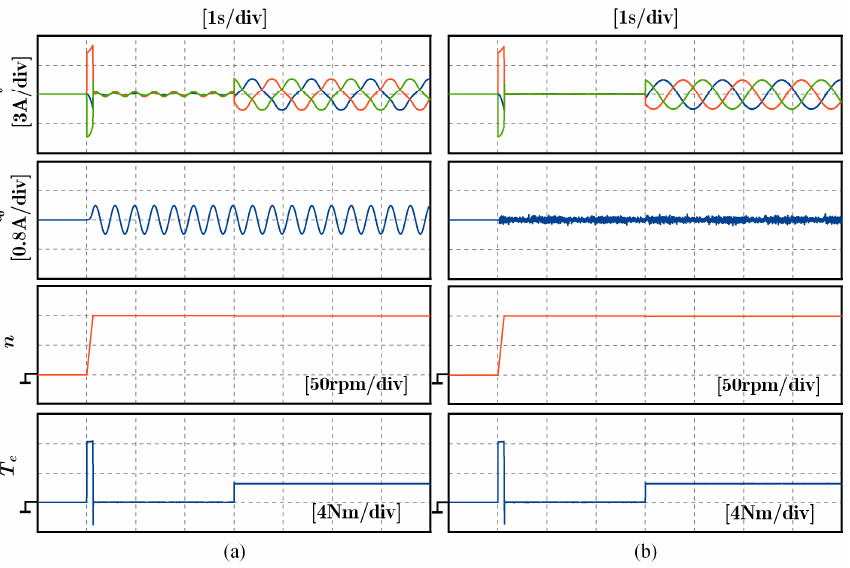
Figure 13. Simulation performance under dynamic test: ( a ) comparison scheme (without zero-sequence loop control); ( b ) proposed scheme (with zero-sequence loop control).